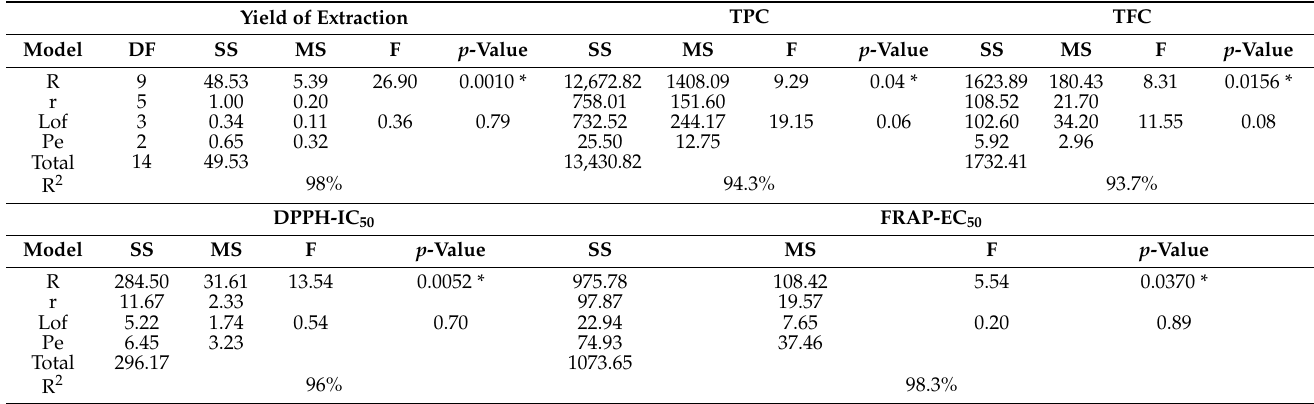
Table 3. Analysis of variance for the three fitted models.